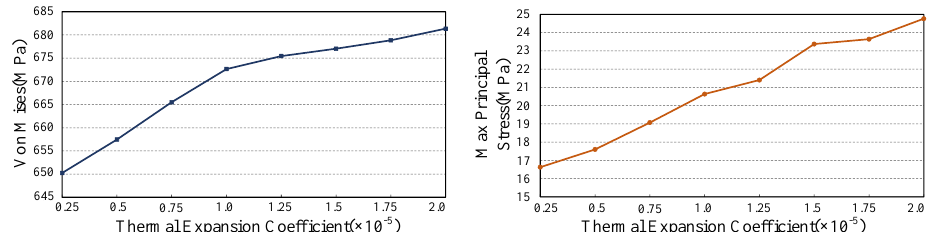
Figure 5. Influence of thermal expansion coefficient on Von Mises stress and maximum princi- pal